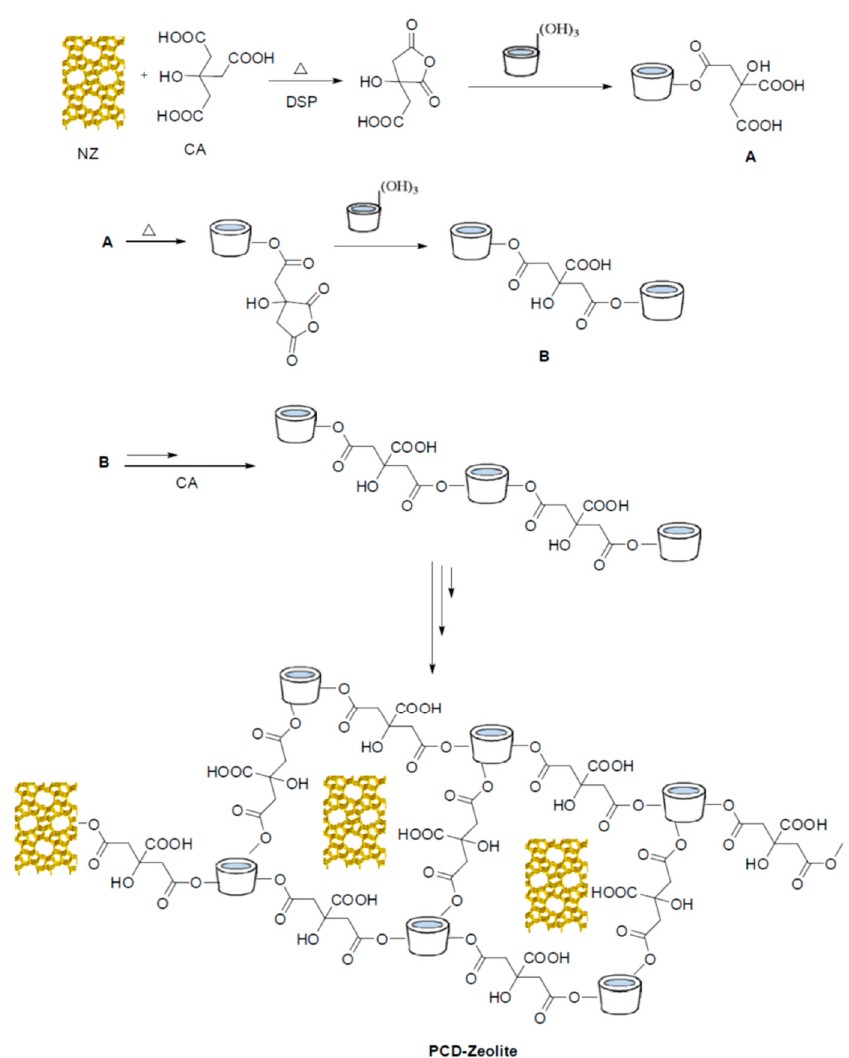
Figure 1. Synthesis approach of polybetacyclodextrin-co-citric acid/NZ clinoptilolite (PCD-Zeolite).